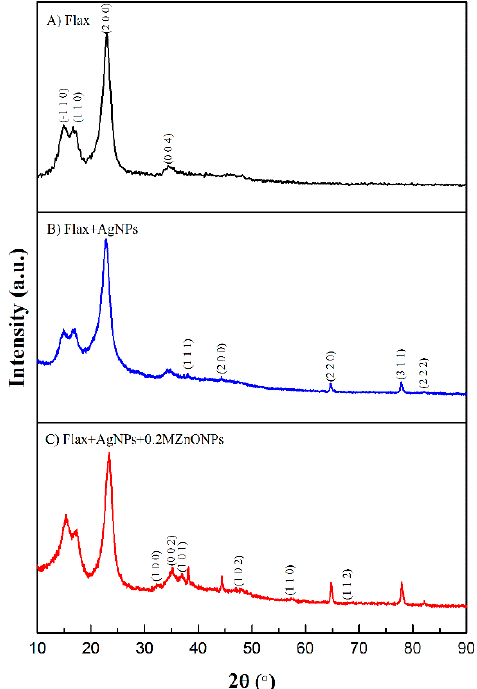
Figure 5. XRD spectra of flax fabric: untreated ( A ), treated with AgNPs ( B ) and treated with Ag and ZnO NPs ( C ).